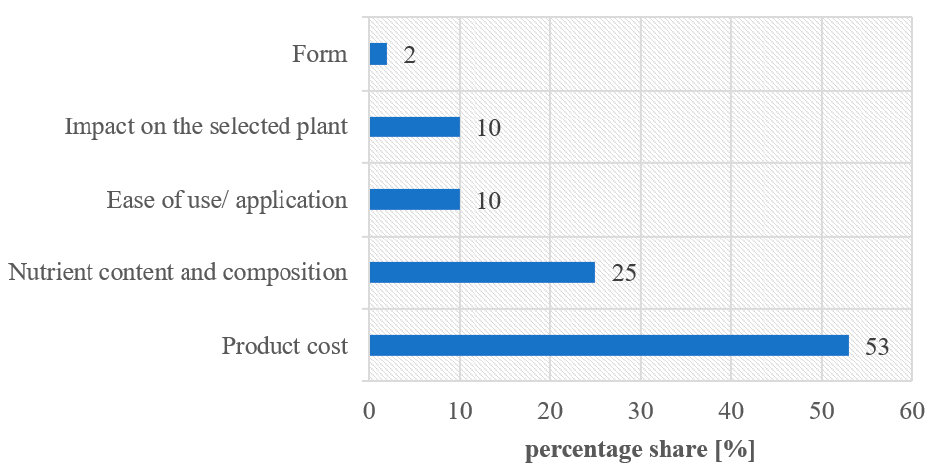
Figure 5. Factors influencing the purchase of fertilizers.